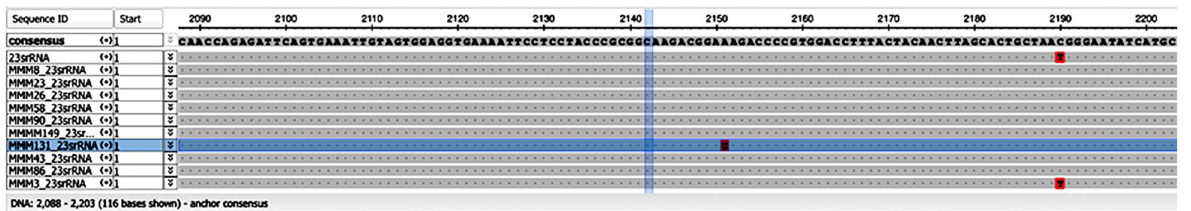
Figure 2. The alignment of 23S rRNA genes by MUSCLE . These region site had been reported to have mutations in the previous study. However, in Myanmar strains, mutation in the locus 2142 or 2147 was not observed.